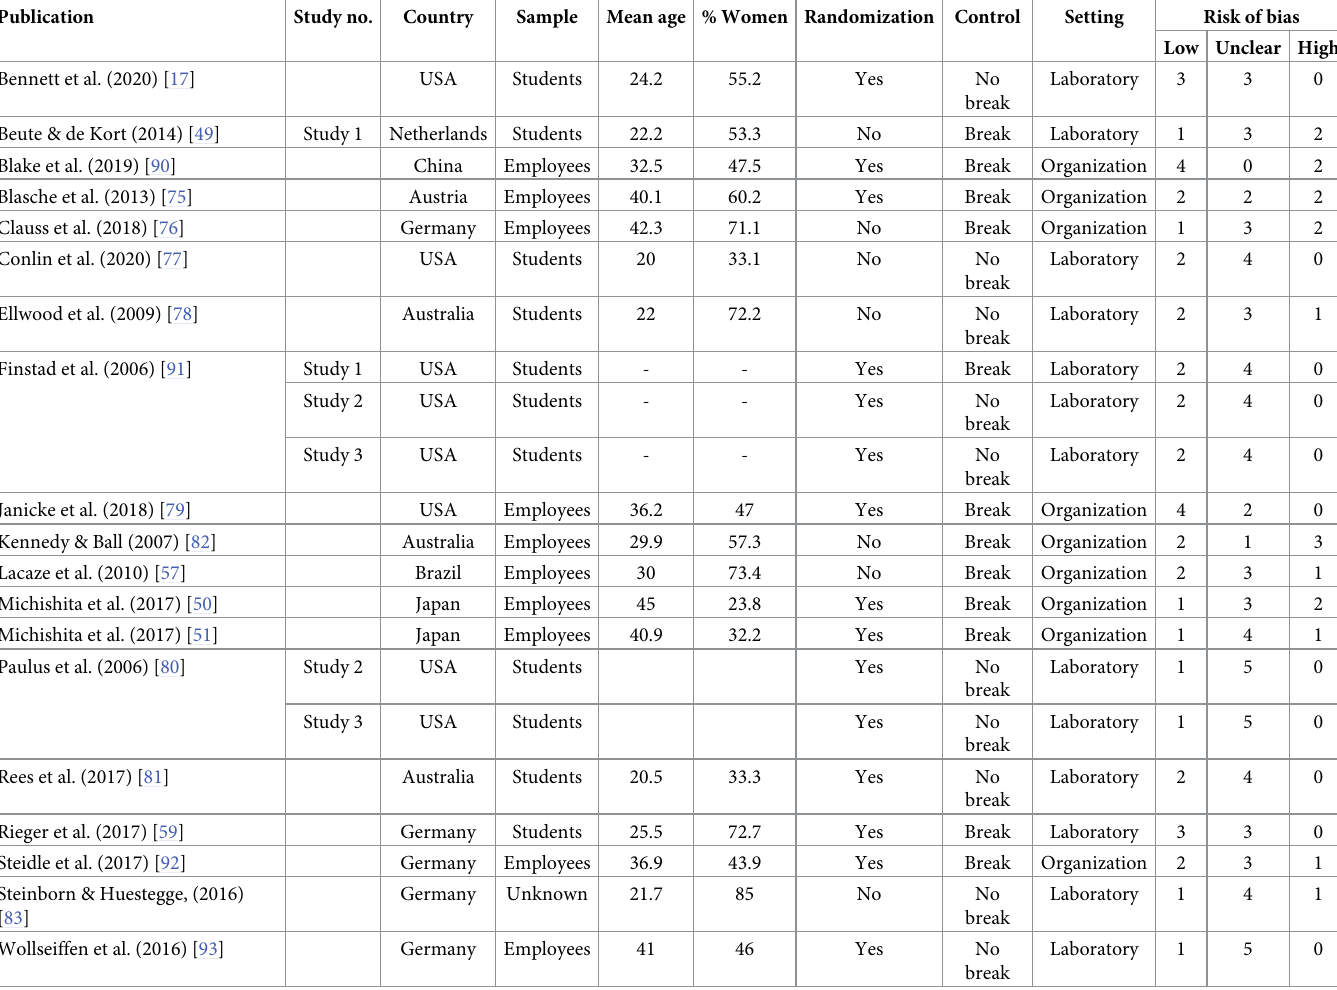
Table 1. Summary of studies included in the meta-analysis and their